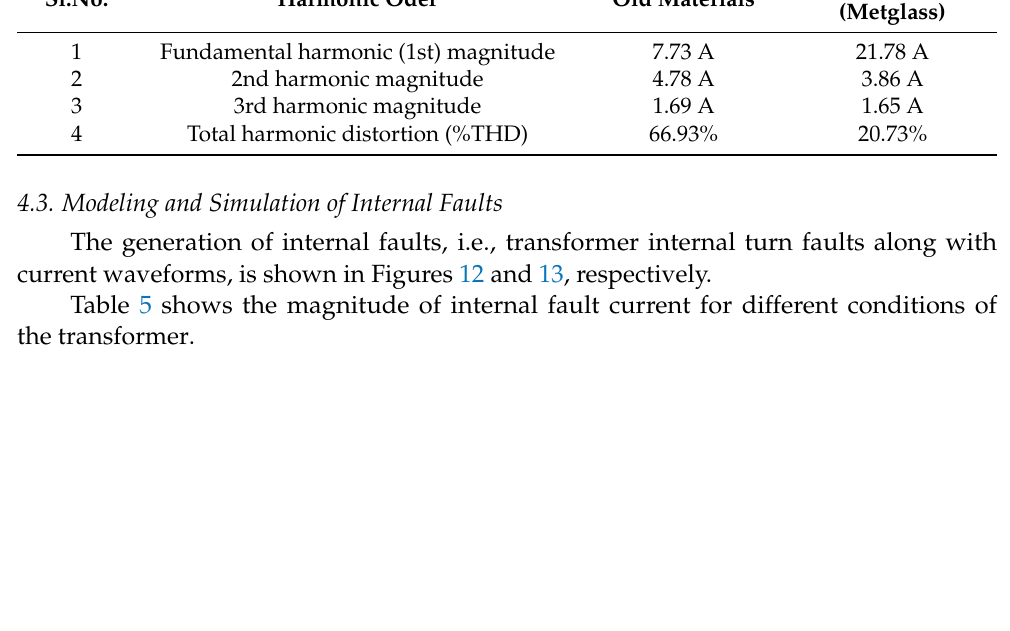
Table 4. Magnitudes of harmonic currents for different metals of the transformer.